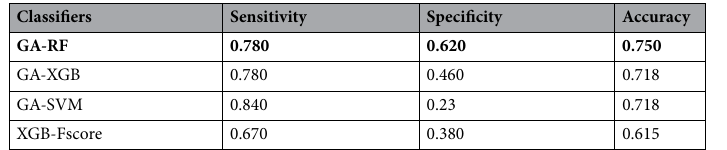
Table 2. Classification performances of the models on the LGG dataset. RF random forest, XGB XGBoost, SVM support vector machine, XGB-Fscore the F-score technique proposed by Le et al. Model with the best performance is indicated in bold